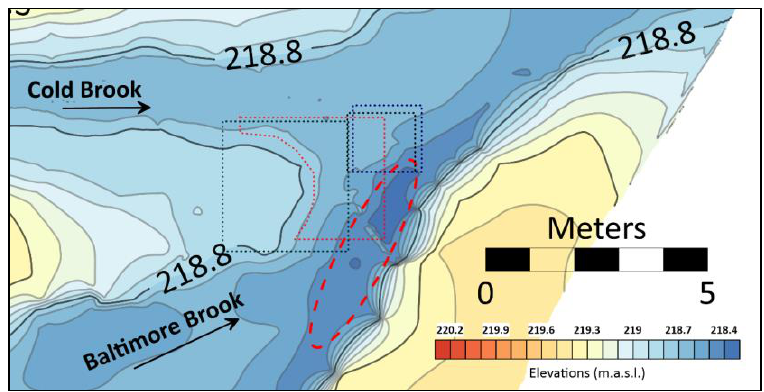
Figure 13. VHF map extents from FS-BBCB1 and FS-BBCB2. The red polygon refers to the September 2018 map; dark green, dark blue, and black recall December 2018, October 2018, and March 2019 maps, respectively. The scour hole is individuated by the red ellipse.